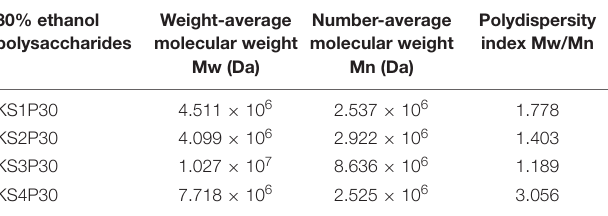
TABLE 1 | Molecular weight distribution of 30% ethanol precipitated polysaccharides obtained from L. edodes at different development stages. 30% ethanol polysaccharides